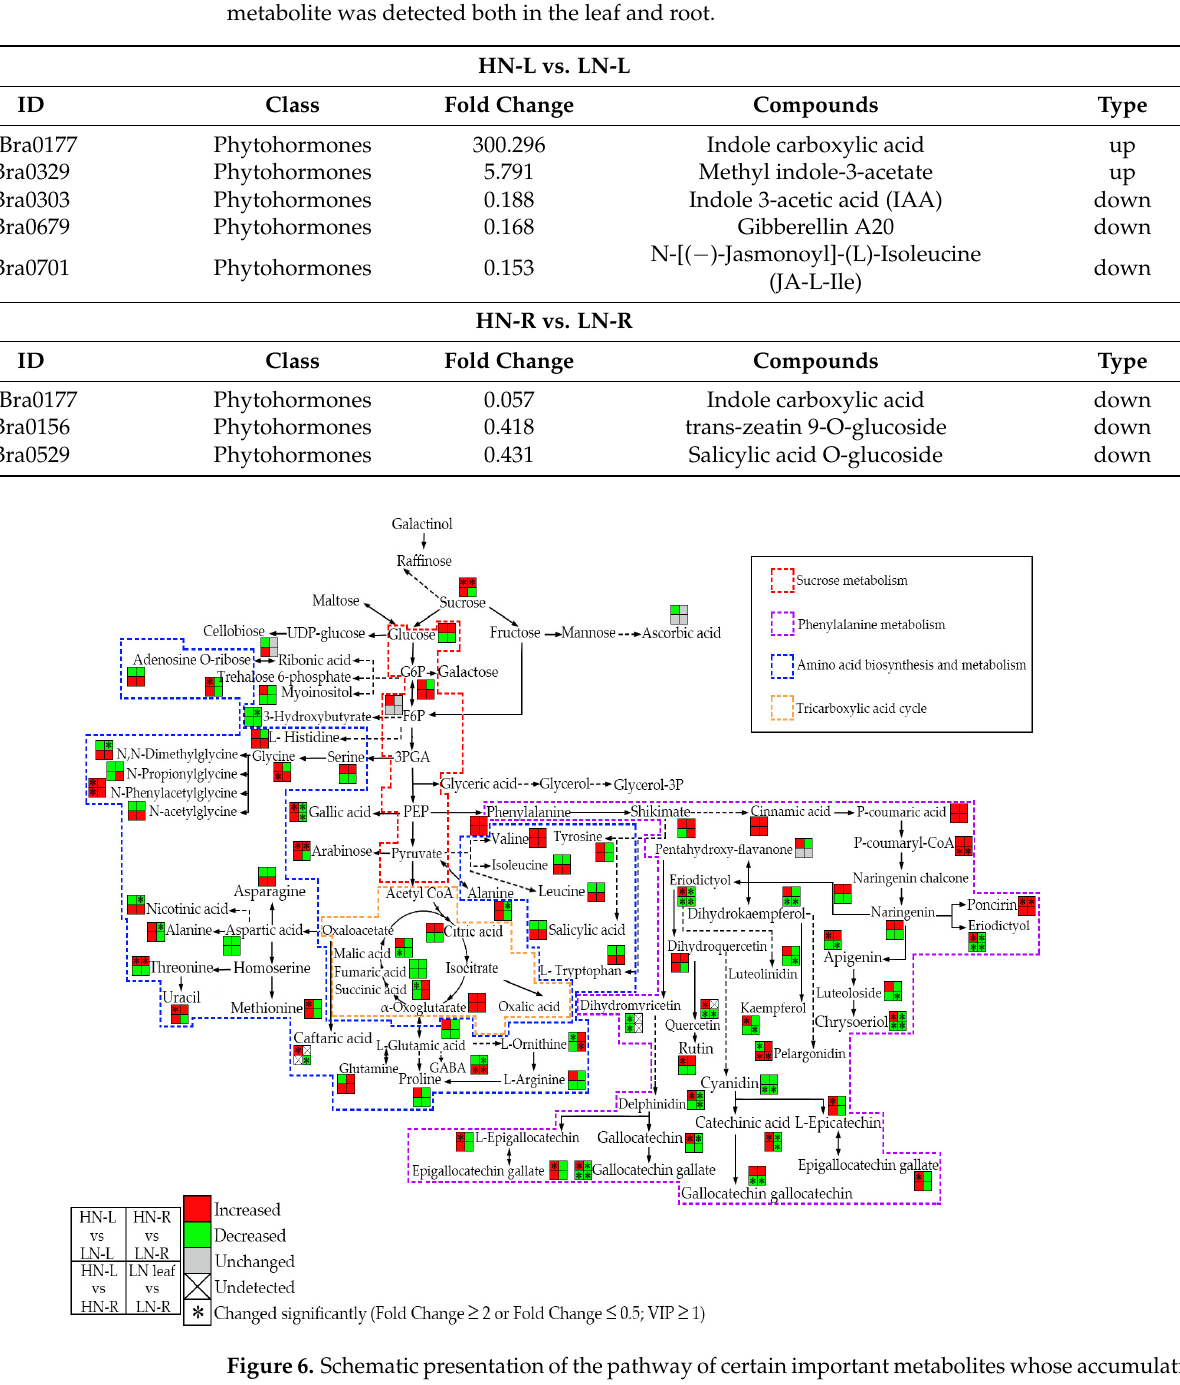
Table 4. Fold change of plant hormones metabolites detected in the HN leaf when compared to the LN leaf, and HN root compared to the LN root, respectively. Asterisk marks indicate that the metabolite was detected both in the leaf and root.